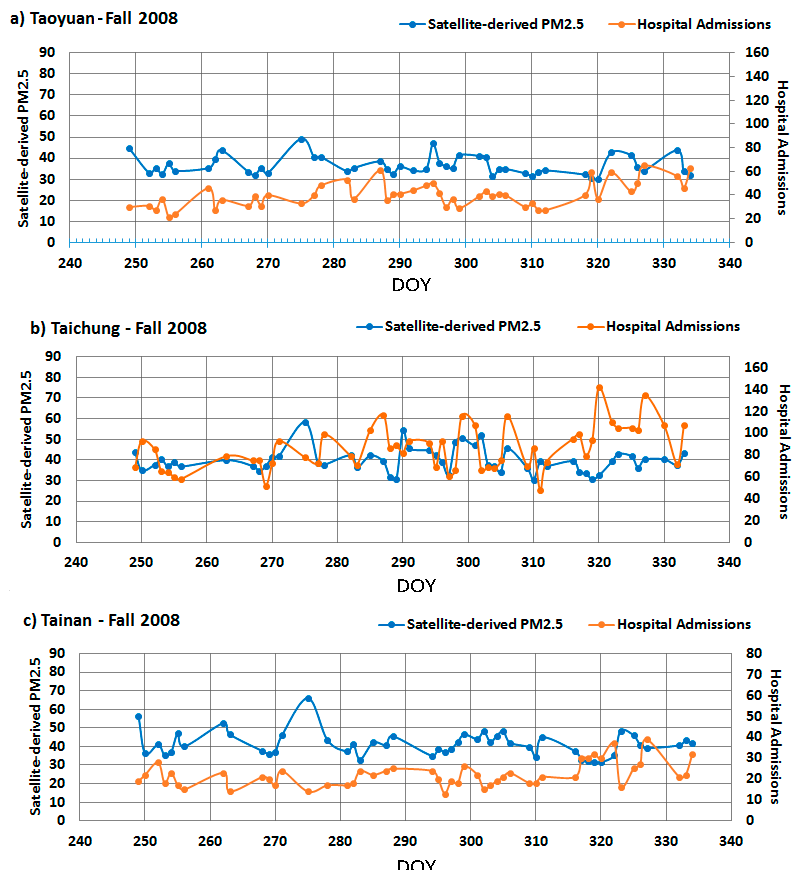
Figure 4. Time-series curves of satellite-derived PM 2.5 levels (blue curves) and hospital admissions for allergic rhinitis (orange curves) in Julian day from 245 to 335 of the year 2008 for Taoyuan ( a ), Taichung ( b ), and Tainan ( c ).